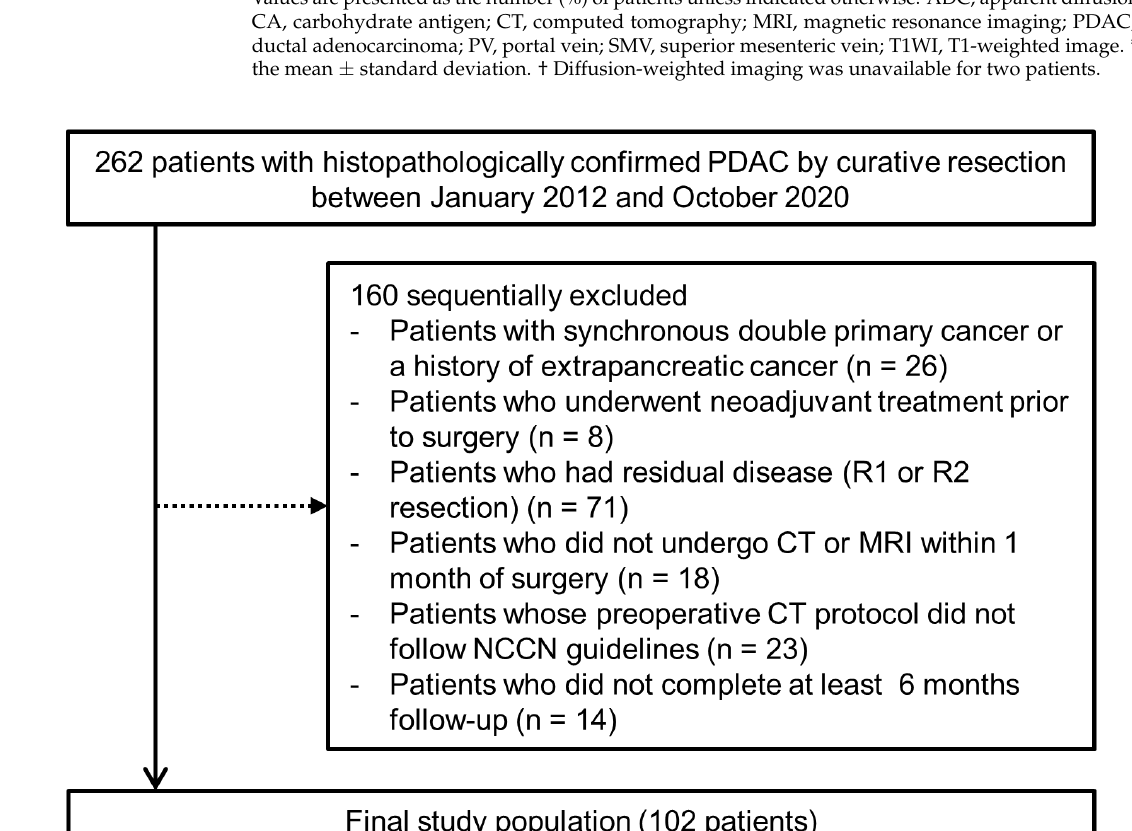
Table 1. Summary of clinical, pathological, and radiological findings of PDAC patients.